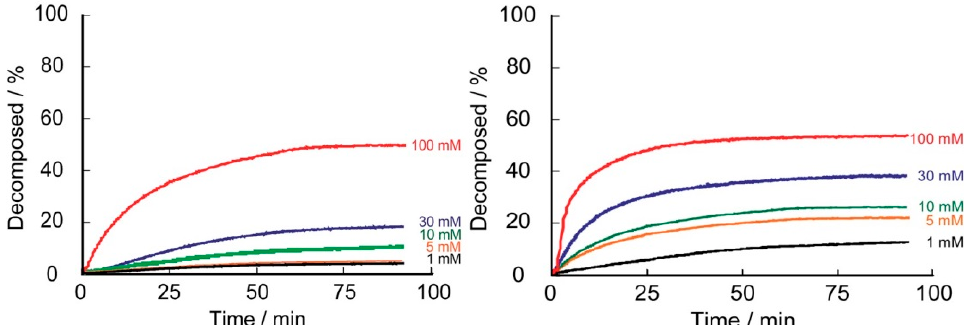
Figure 5. Glucose-induced decomposition of (PVA/3CPBA-PAMAM) 10 ( left ) and (PVA/3C5NPBA- PAMAM) 10 ( right ) films in 1–100 mM glucose solutions at pH 7.4 and 37 °C. Reprinted with permission from Ref. [55]. Copyright 2014 Royal Society of Chemistry.